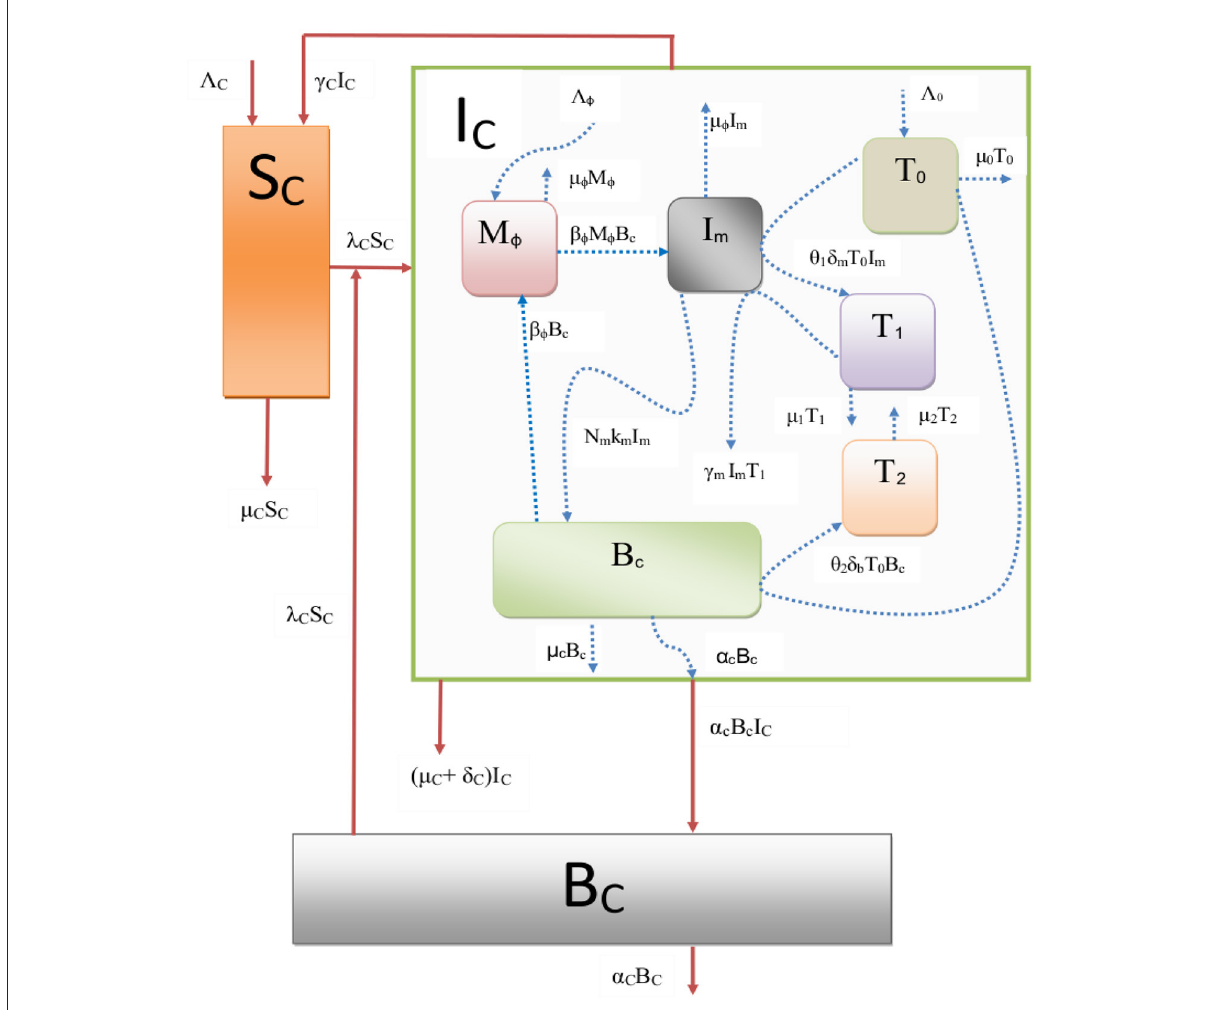
FIGURE1 A schematic representation of the nested multiscale model of paratuberculosis disease in ruminants, with λ C = β C B C / ( B 0 + B C